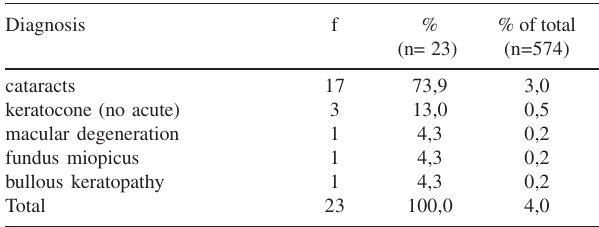
Table 4 - Diagnostics of patients with degenerative disorders that looked for ophthalmology emergency room of the University of São Paulo Medical School General Hospital